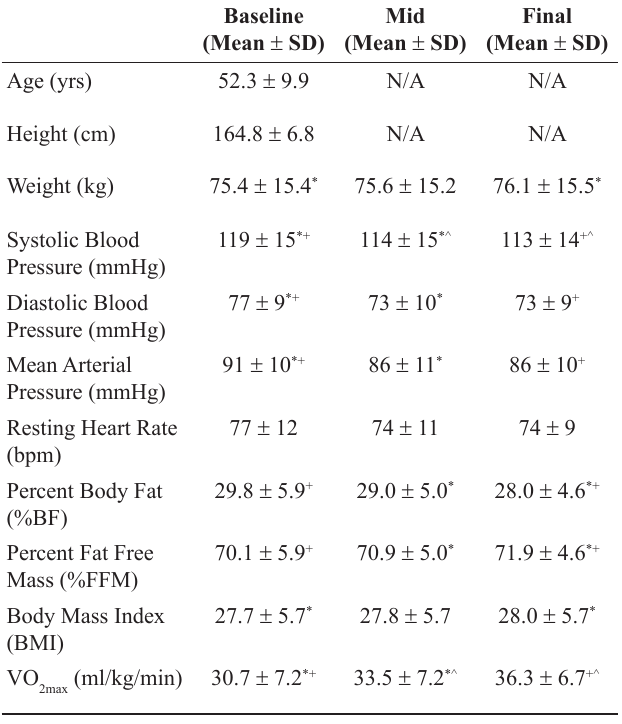
Table 2. Participant’s characteristics and mean ± standard deviations of all parameters evaluated in the study ( n